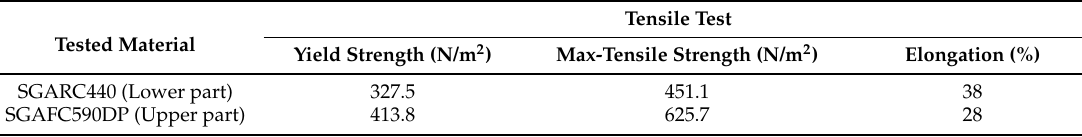
Table 4. Mechanical properties of the test materials.